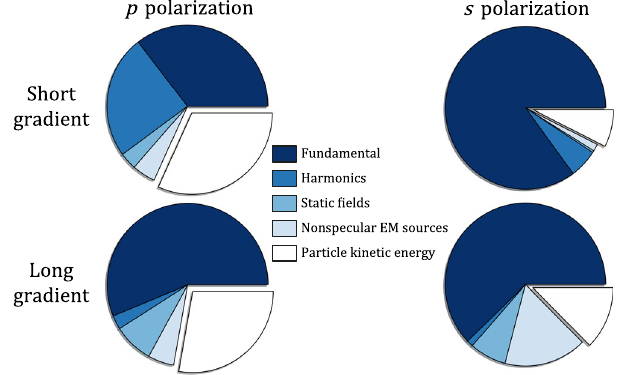
FIG. 11. Distribution of the initial laser pulse energy after the interaction, in different conditions. These pie charts summarize how the laser energy is distributed after the laser-plasma inter- action, in the short-gradient (upper line) and long-gradient (lower line) regimes, for p (left-hand column) and s (right-hand column) polarizations. Five categories have been numerically separated, indicated in the legend: electromagnetic (EM) energy in the fundamental laser frequency in the specular direction, in the harmonics of the laser frequency in the specular direction, in quasistatic fields (i.e., with a frequency lower than the laser frequency), in nonstatic fields in the nonspecular direction, and kinetic energy of plasma particles. The results are obtained from 2D PIC simulations with a 0 ¼ 3 , θ i ¼ 55 °, and L 1 ¼ λ = 15 for the short-gradient regime and L 2 ¼ λ = 1 . 5 in the long-gradient